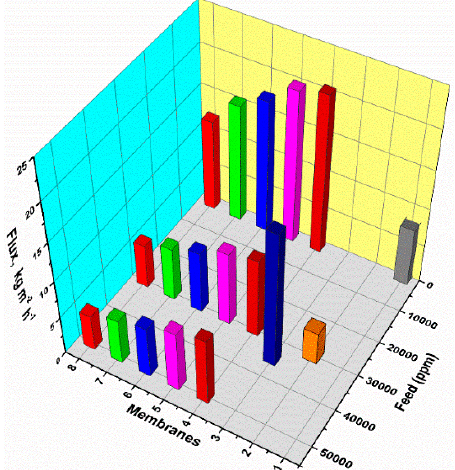
Figure 20. Variation of flux as the function of feed concentrations of different membranes (1: PEBA/PAN/PE, 2: 20zeolite 3A/PEBA, 3: GO/CS, 4: PVA-SiO 2 /PVSF hollow fiber (thickness: 0.22 ± 0.03 μ m), 5: PVA-SiO 2 /PVSF hollow fiber (thickness: 0.30 ± 0.03 μ m), 6: PVA-SiO 2 /PVSF hollow fiber (thickness: 0.60 ± 0.05 μ m), 7: PVA-SiO 2 /PVSF hollow fiber (thickness: 0.85 ± 0.07 μ m), and 8: PVA-SiO 2 /PVSF hollow fiber (thickness: 1.13 ± 0.11 μ m) at 60 °C.